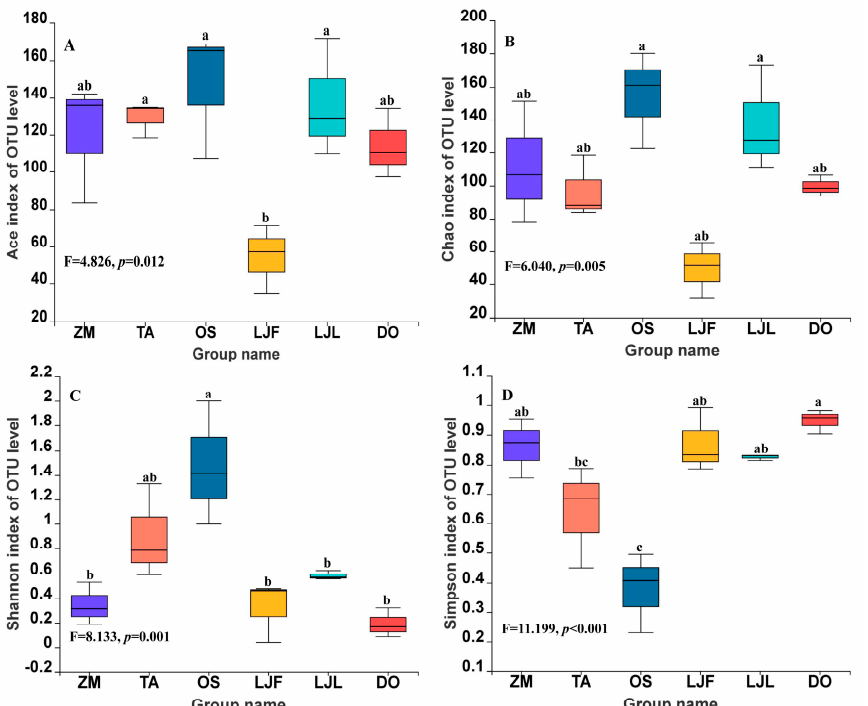
Figure 1. Box plots of gut microbiota diversity of Spodoptera frugiperda fed on different host plants. ( A ) ACE index, ( B ) Chao index, ( C ) Shannon index, ( D ) Simpson index. Abbreviations in the figure represent different treatments: ZM, maize; TA, wheat; OS, rice; LJF, honeysuckle flowers; LJL, honeysuckle leaves; and DO, Chinese yam. Lowercase letters above the boxes indicate significant differences between different treatments (one − way ANOVA, Tukey’s test, α = 0.05).